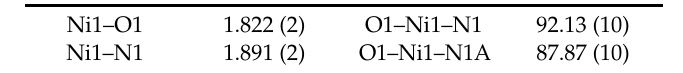
Table 3. Selected bond lengths (Å) and angles (°) for 2 .